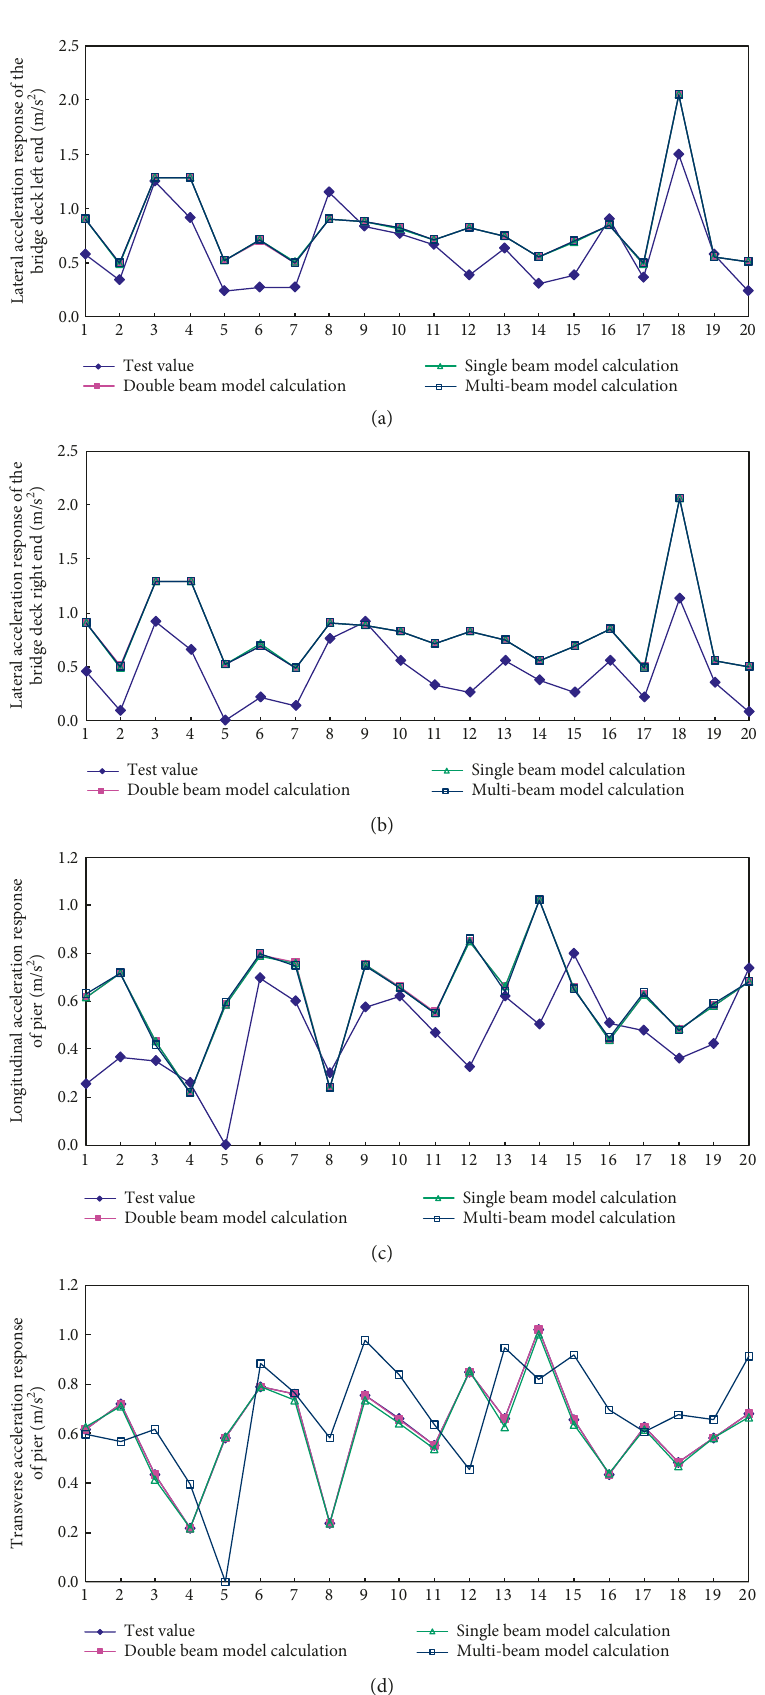
Figure 4: Acceleration response under transverse seismic waves. (a) Left end of bridge deck. (b) Right end of bridge deck. (c) Longitudinal acceleration response of pier. (d) Transverse acceleration response of